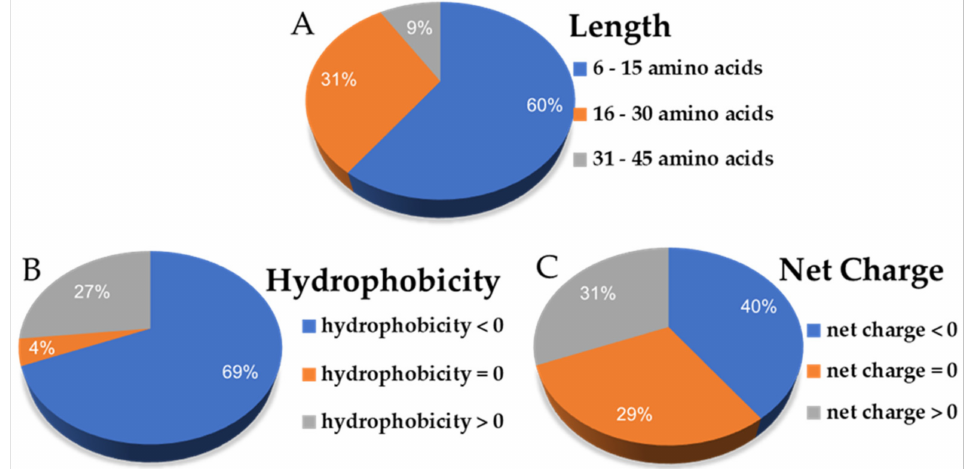
Figure 2. The distribution ratio in each class of general peptides features such as peptide length ( A ), hydrophobicity ( B ), and net charge ( C ) from 45 putative